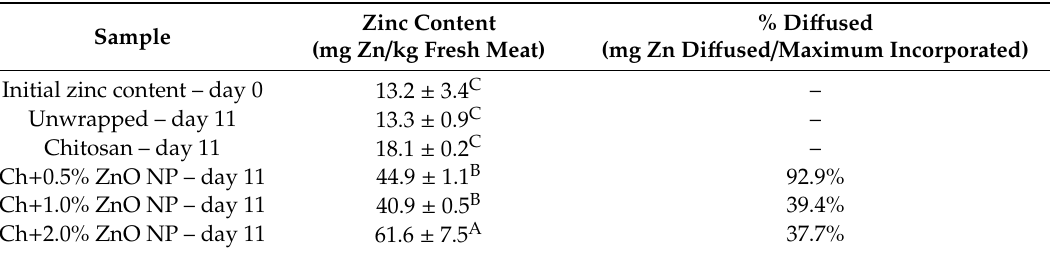
Table 3. Total zinc